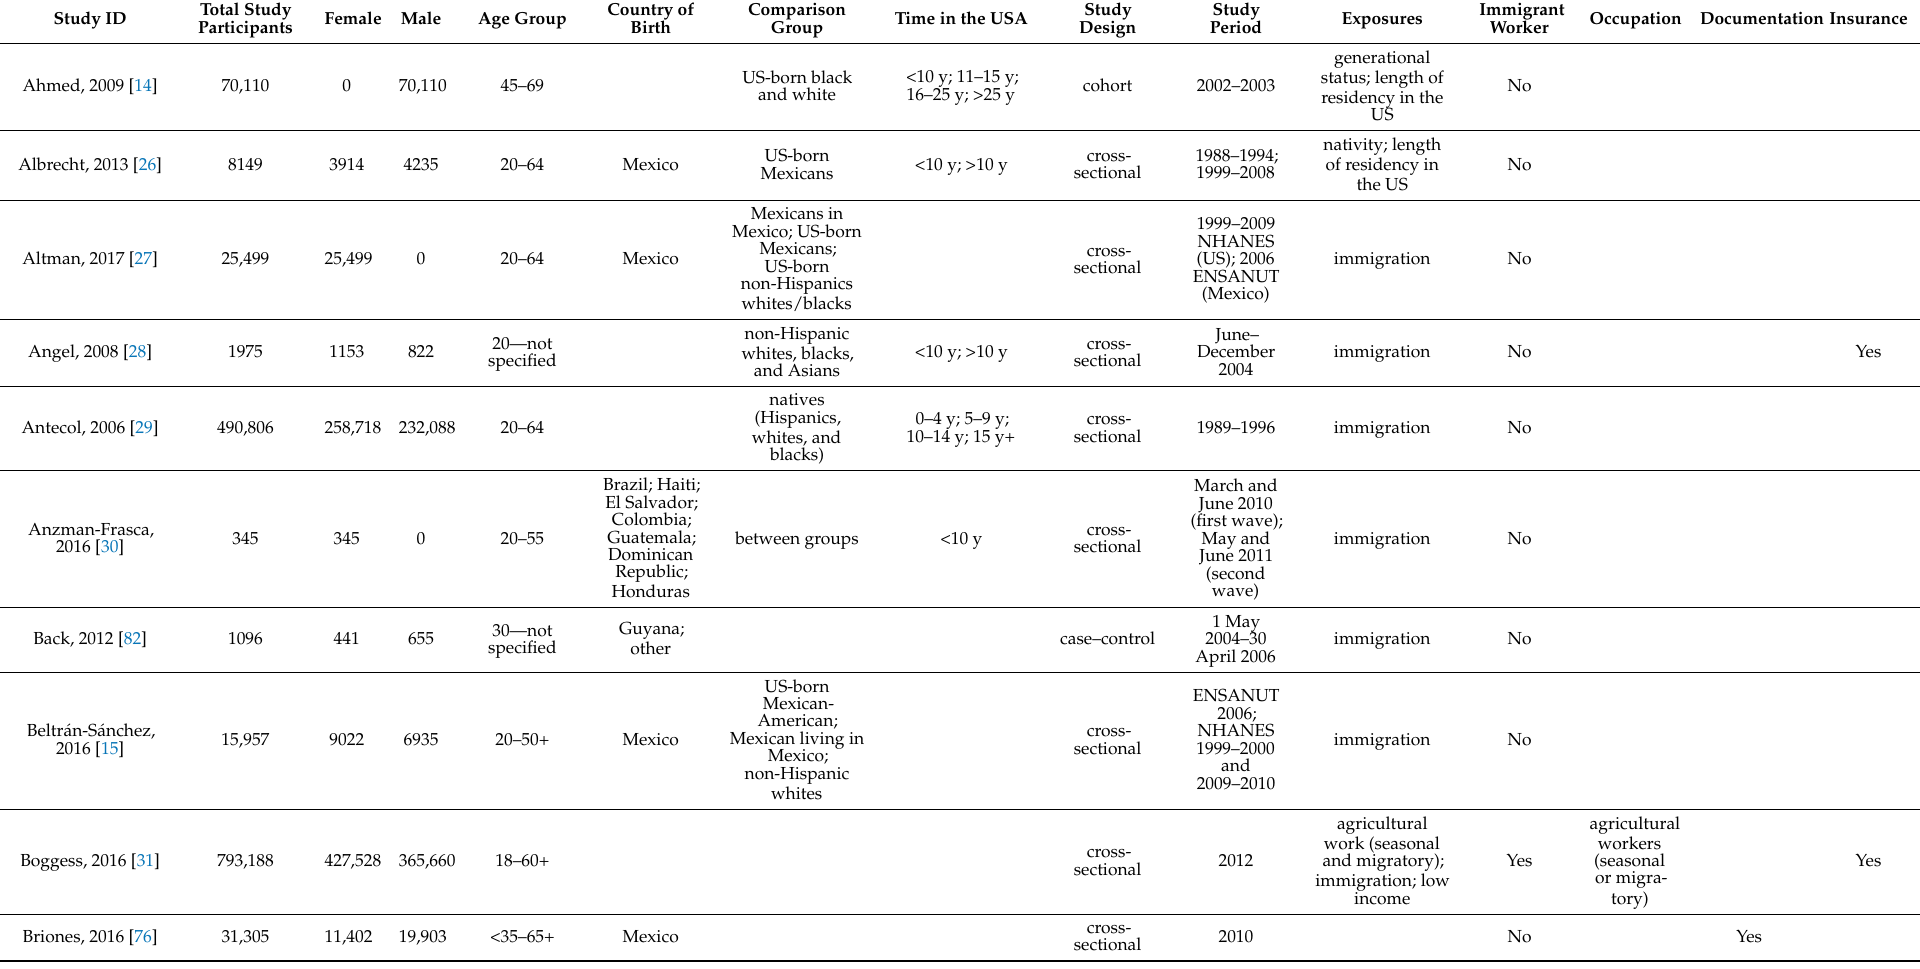
Table 2. Characteristics of Latinos in the USA studies